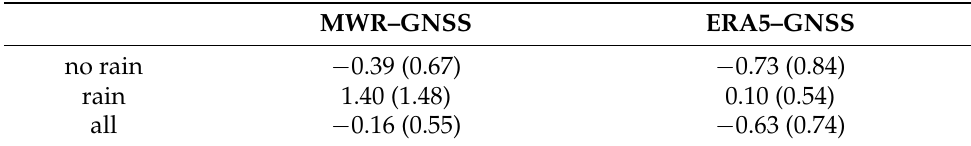
Table 5. Mean differences of IWV (mm) and RMSE of MWR (microwave radiometer) and ERA5 with respect to GNSS. The deviations are listed for the different atmospheric states at Bern. In difference to Table 4, rain periods are indicated by ILW ≥ 0.2 mm, and hourly averages of the MWR data are